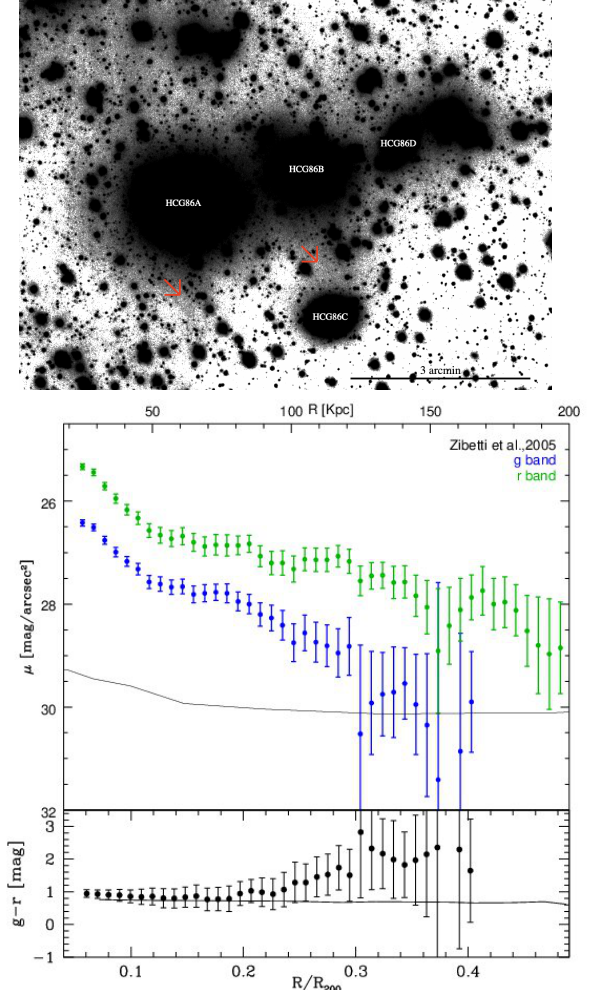
Figure 5. Upper panel: The central part of the cluster group HCG 86, with the four dark spots being the brightest group members. Low-surface brightness filaments and bridges represent the ICL (two of them are indicated by red arrows). The lower panel shows azimuthally averaged color ( g and r ) radial profiles (points with error bars) and compares them with the stacked radial profile (solid line) for a set of ∼ 600 galaxy clusters from [151]; HCG 86 and clusters’ radii normalized to their R 200 . Credit: Ragusa et al. [150]. A&A, 651, A39, 2021, reproduced with permission ©